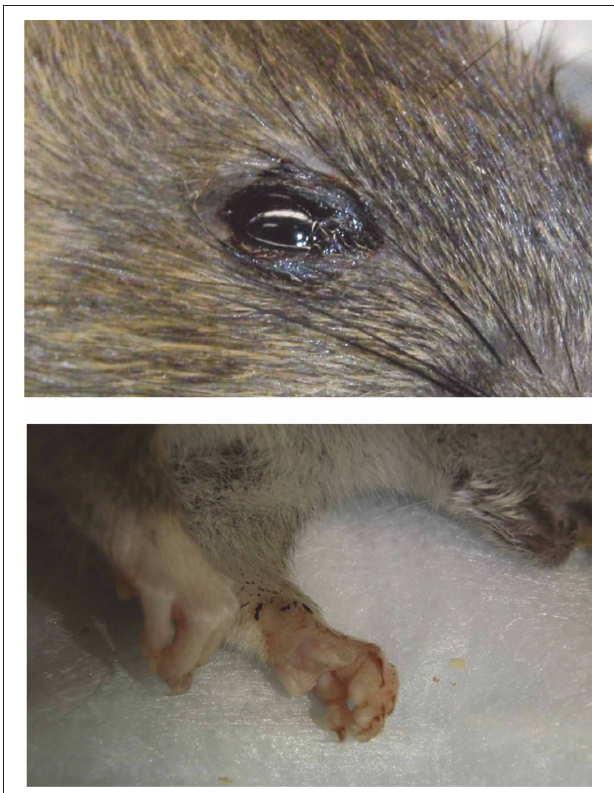
FIGURE 7 | Example of porphyrin staining in ACI rats. Chromodacryorrhea (dried porphyrin) on the eye and paw of ACI rat H1 immediately prior to euthanasia (14